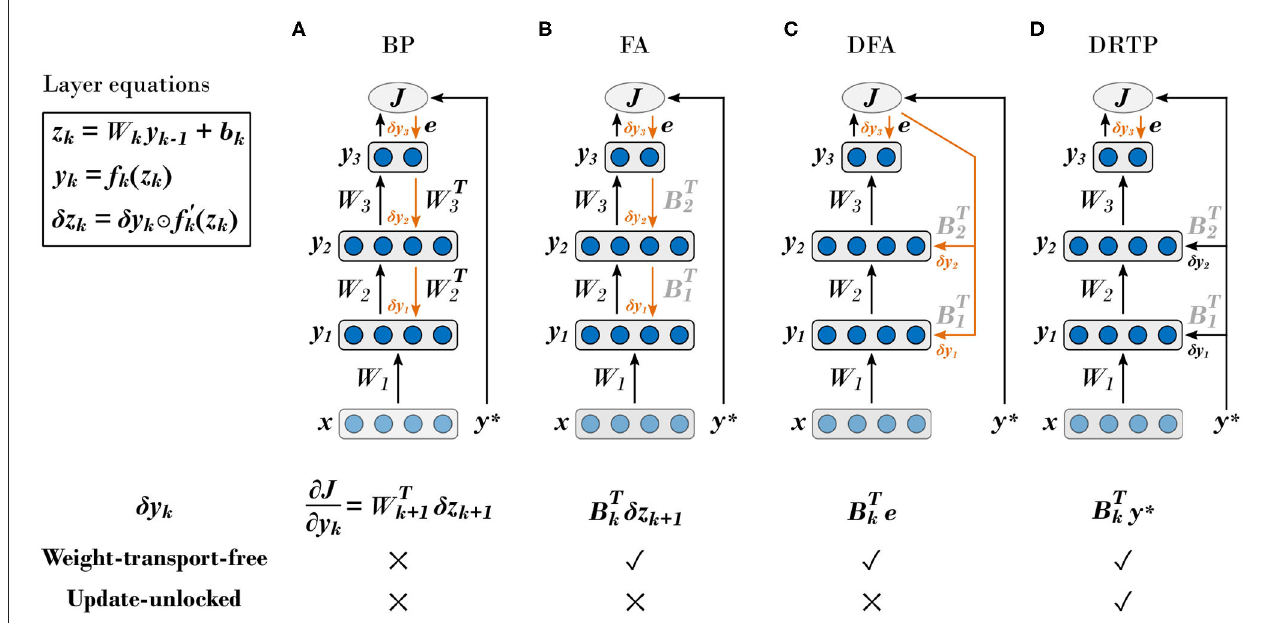
FIGURE 1 | The proposed direct random target projection algorithm builds on feedback-alignment-based algorithms to tackle the weight transport problem while further releasing update locking. Black arrows indicate the feedforward pathways and orange arrows the feedback pathways. In the k -th layer, the weighted sum of inputs y k − 1 is denoted as z k , the bias as b k , the activation function as f k ( · ) and its derivative as f ′ k ( · ), with k ∈ [1, K ], k ∈ N , and K the number of layers. Trainable forward weight matrices are denoted as W k and fixed random connectivity matrices as B k . The input vector is denoted as x , the target vector as y ∗ and the loss function as J ( · ). The estimated loss gradients for the outputs of the k -th hidden layer, denoted as δ y k , are provided for each training algorithm. The layer equations for z k , y k and δ z k , defined as the modulatory signals, are provided in the upper left corner, with ⊙ denoting the elementwise multiplication operator. (A) Backpropagation of error (BP) algorithm (Rumelhart et al., 1986). (B) Feedback alignment (FA) algorithm (Lillicrap et al., 2016). (C) Direct feedback alignment (DFA) algorithm (Nøkland, 2016). (D) Proposed direct random target projection (DRTP) algorithm. Adapted from Nøkland (2016) and Czarnecki et al.